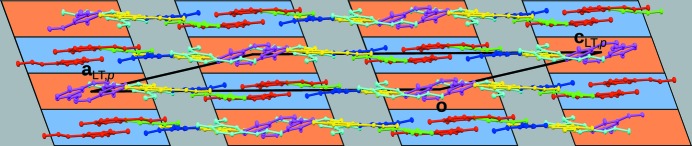
The LT phase viewed down b
LT. Molecules are coloured according to space-group symmetry equivalence, and the background is coloured according to equivalence by partial operations (colour codes as in Fig. 5 ▸).